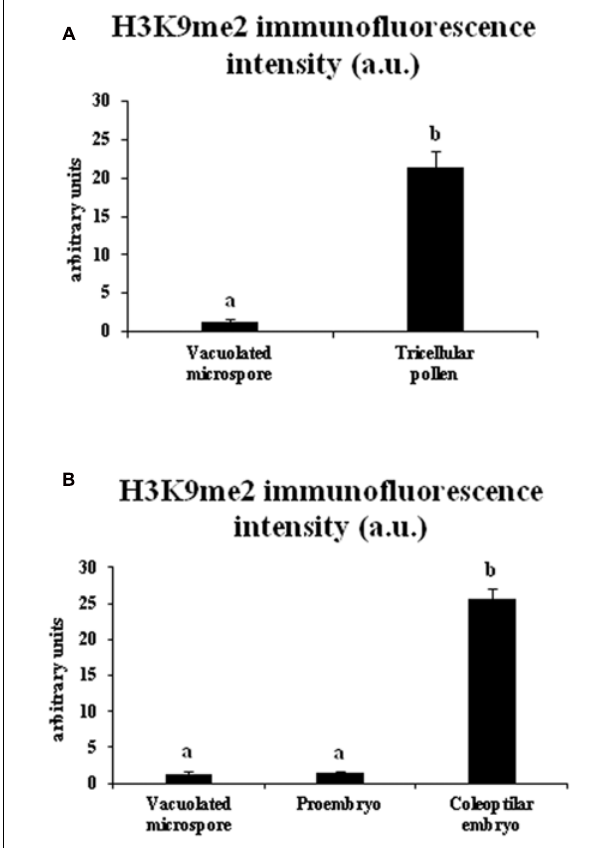
FIGURE 6 | Quantification of global H3K9 methylation during pollen development and microspore embryogenesis of Brassica napus . Histograms represent the amount of H3K9 methylation, in optical density (OD) units at 450 nm (see Materials and Methods), in different stages of the two microspore pathways, gametophytic development ( A : vacuolated microspore and tricellular pollen), and microspore embryogenesis ( B : vacuolated microspore, proembryo and cotyledonary embryo). Columns represent mean optical density (OD) units at 450 nm ( ± SEM). Different letters indicate significant differences according to ANOVA and Tukey’s test at p ≤